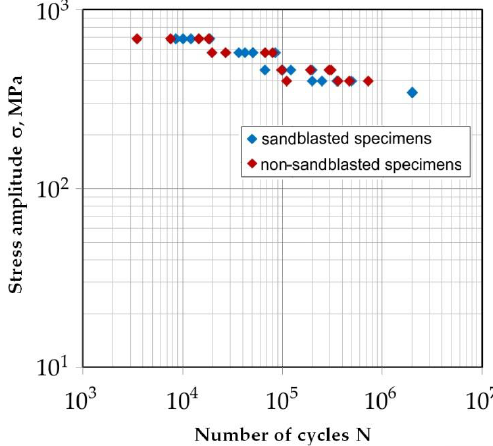
Figure 5. Comparison of the fatigue strength of sandblasted and non-sandblasted specimens. Table 3. Results of the statistical analysis of the fatigue tests for non-sandblasted specimens. Parameter Values for Individual Specimens Stress Amplitude σ , MPa